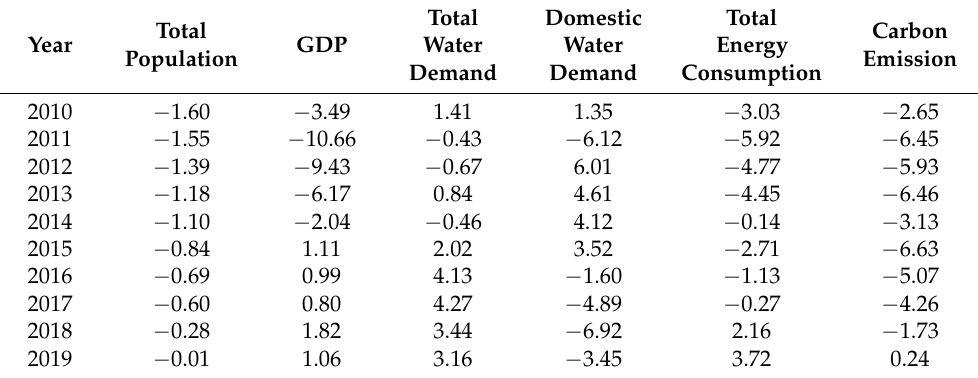
Table 1. Relative error of the main variables in the population, economic, water resources, and energy simulation for Hebei urban metabolic system (unit: